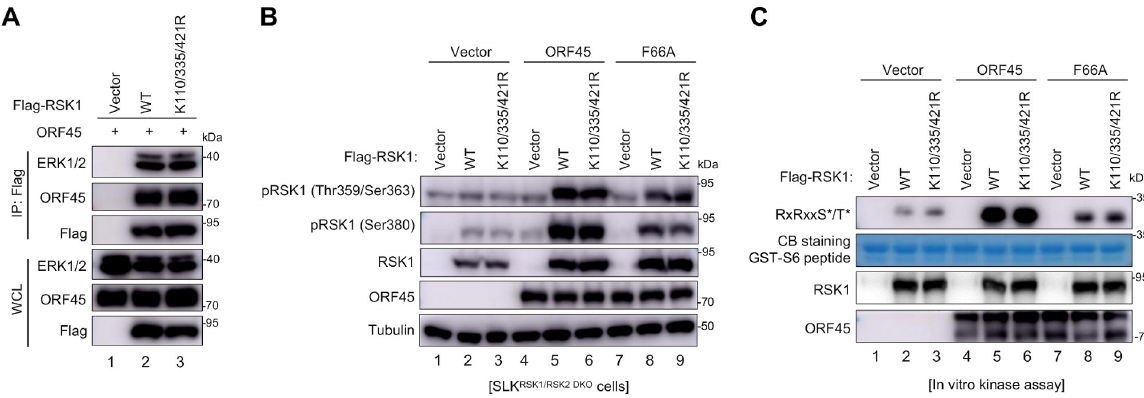
Fig 4. RSK1 SUMOylation does not alter its activation or kinase activity. ( A ) SUMOylation site mutations of RSK1 do not change ERK-RSK-ORF45 complex formation. HEK293T cells were co-transfected with indicated plasmids and cell lysates were subjected to IP and IB with indicated antibodies. ( B ) SUMOylation site mutations do not affect RSK1 phoshporylation by KSHV ORF45. SLK RSK1/2 DKO -vector, SLK RSK1/2 DKO -RSK1 and SLK RSK1/2 DKO -RSK1 K110/335/421R cells were infected with lentiviruses containing empty vector, ORF45 WT or ORF45 F66A as indicated. The cells were serum-starved for 24h before sample collection and cell lysates were analyzed by IB with indicated antibodies at 48 h post-transfection. ( C ) SUMOylation site mutations do not affect RSK1 kinase activity in vitro (Methods section). RSK1 kinase complexes with or without ORF45 were purified from HEK293A cells transfected with indicated plasmid. GST-S6 peptide was purified from E . coli . RSK1 (5 μ l) were mixed with GST-S6 (2.5 μ g) in kinase assay buffer at 30 ˚C for 30 min. The reaction was stopped by adding 2 x SDS-PAGE loading buffer, followed by IB analysis with indicated